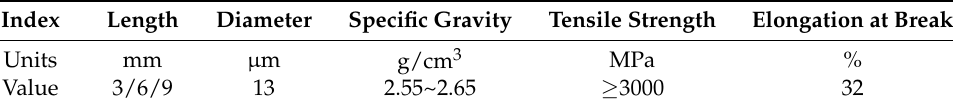
Table 3. Physical properties of basalt fiber.